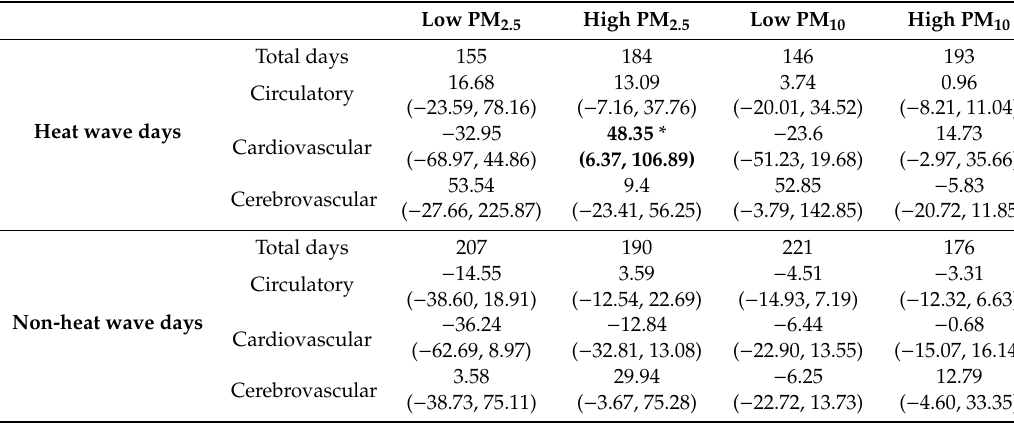
Table 3. The e ff ect of days with heat waves and days without heat waves on circulatory mortality with high levels of particulate matter compared to days with low levels of particulate matter. E ff ects are presented as excessive risk with their corresponding 95% confidence intervals a